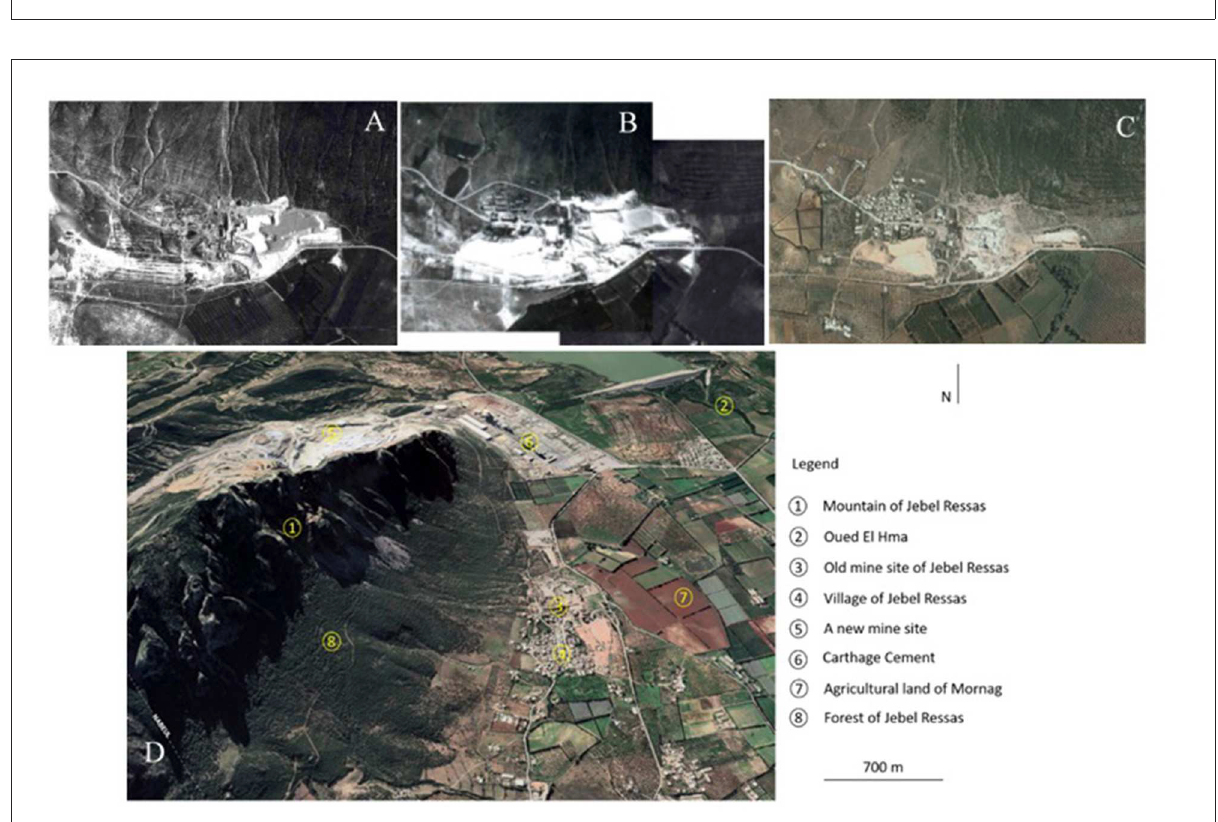
FIGURE3 (A) The mining site of Jebel Ressas in 1947. (B) 1963 with the first miners’ houses (Aerial Photographs). (C) 2004 (Google Earth) with a dispersed habitat. (D) The mining site and the village of Jebel Ressas with a urbanization around the quarry/cement factory facility of the Cement Carthage company in 2021 (Google